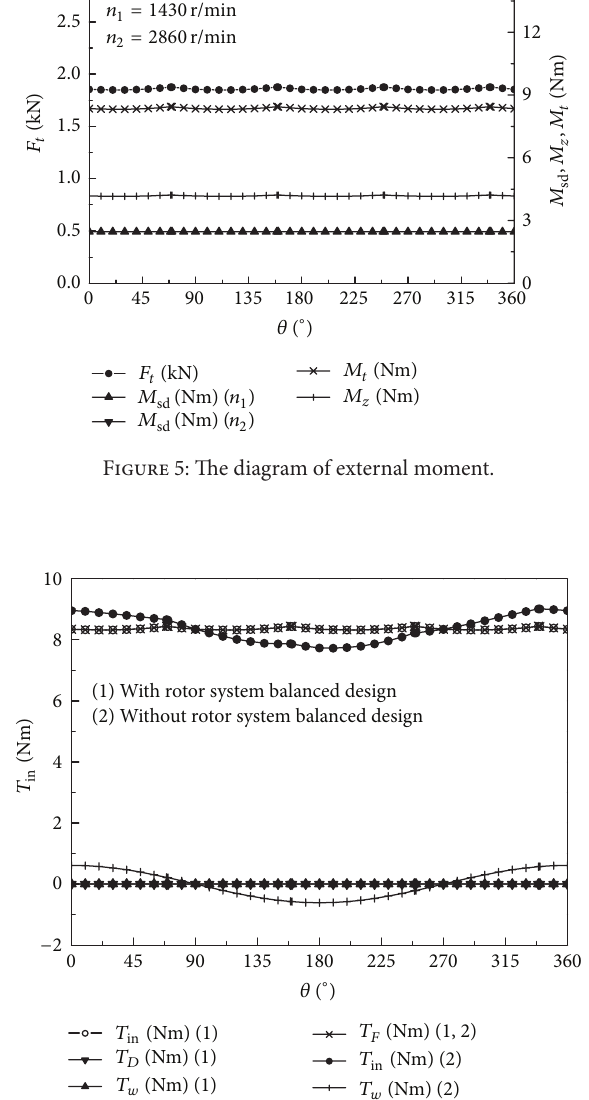
Figure 6: The diagram of input torque in ideal